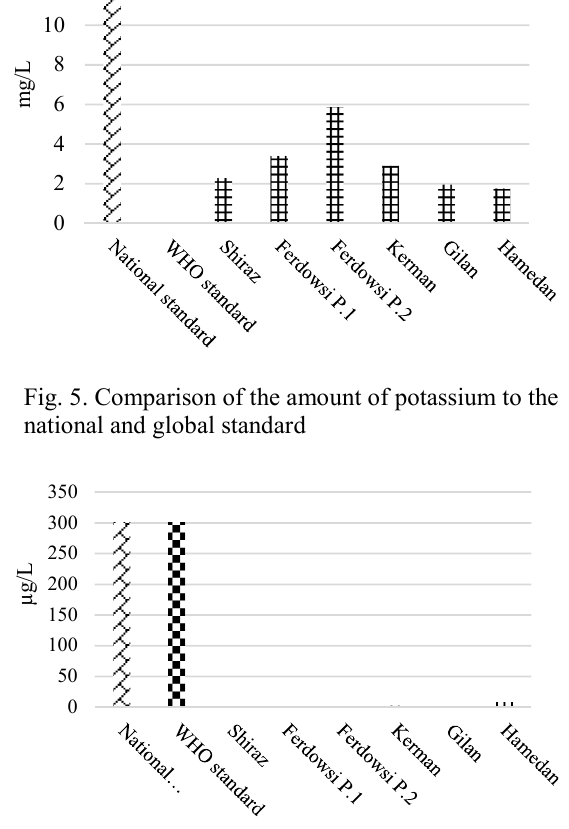
Fig. 9. Comparison of the amount of bromoform to the national and global